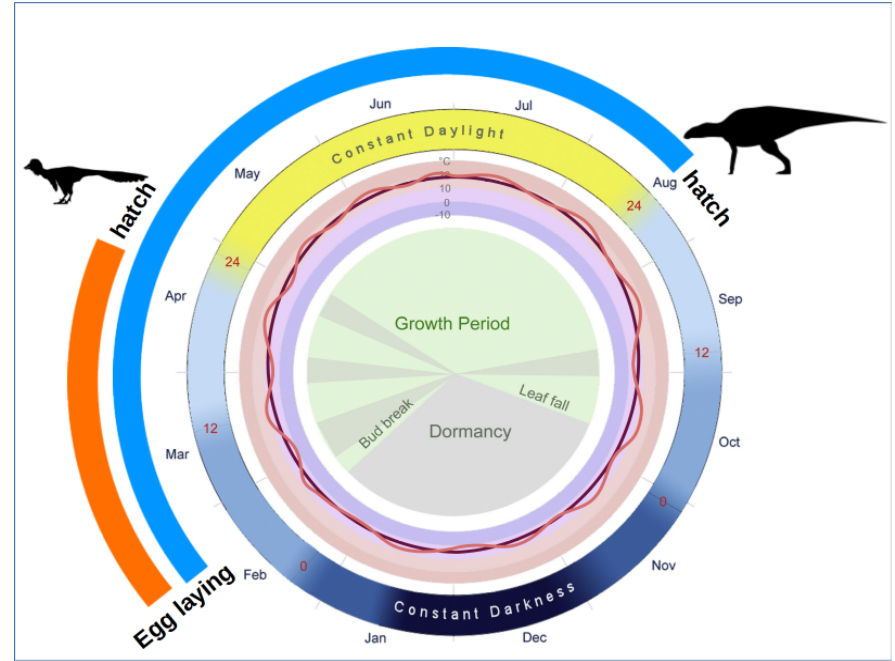
Figure 4. Incubation periods of the eggs from the troodontid (orange arc) and hadrosaurid (blue arc) taxa are drawn based on the present study and the incubation duration estimated for both taxa [18,68], superimposed on the summary graphic of the annual cycle of light, temperature and phenology in the early Maastrichtian at 76 ◦ N published by Herman et al. [69]. The outer ring shows the variations in insolation and the red numbers indicate the hours each day (24 h period) when the sun is above the horizon. The inner rings show the temperature regime. The solid red line shows the average temperature variations based on interpolations from the mean annual temperature, the cold month mean and the warm month mean temperatures. The pink line shows the estimated short-term temperature variations based on tree ring data. The center of the diagram shows the proportion of the year when plant growth and dormancy